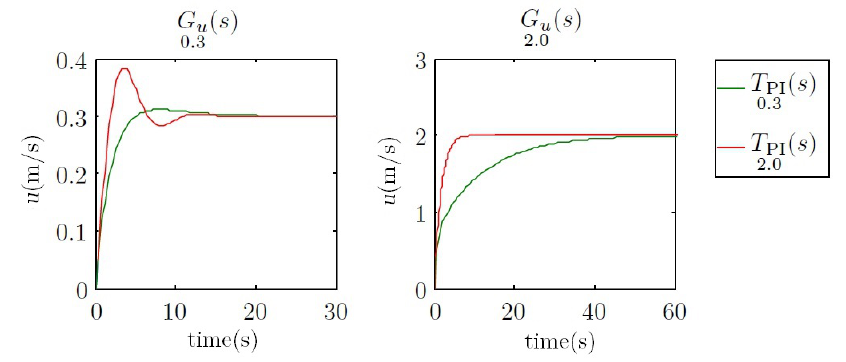
Figure 12. Step response of the systems G u 0.3 ( s ) and G u 2.0 ( s ) using the controllers T PI 0.3 ( s ) and T PI 2.0 ( s ) in a feedback loop. The two time scales are different for a better response appreciation between controllers at different velocities.